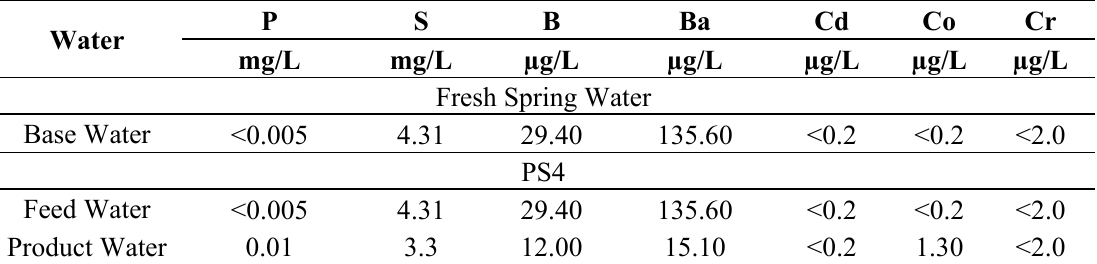
Table C3. Measured Cation Concentrations in the Feed and Product